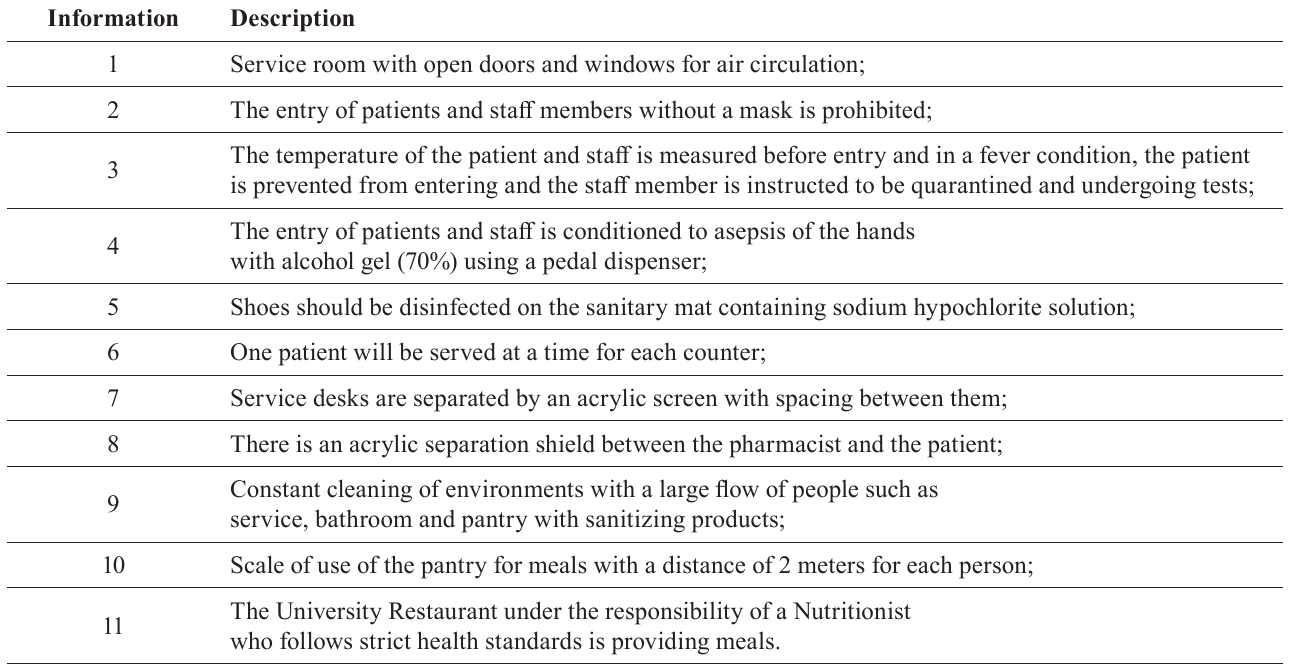
TABLE II - Adjustments to the public service sector to protect against the spread of COVID-19